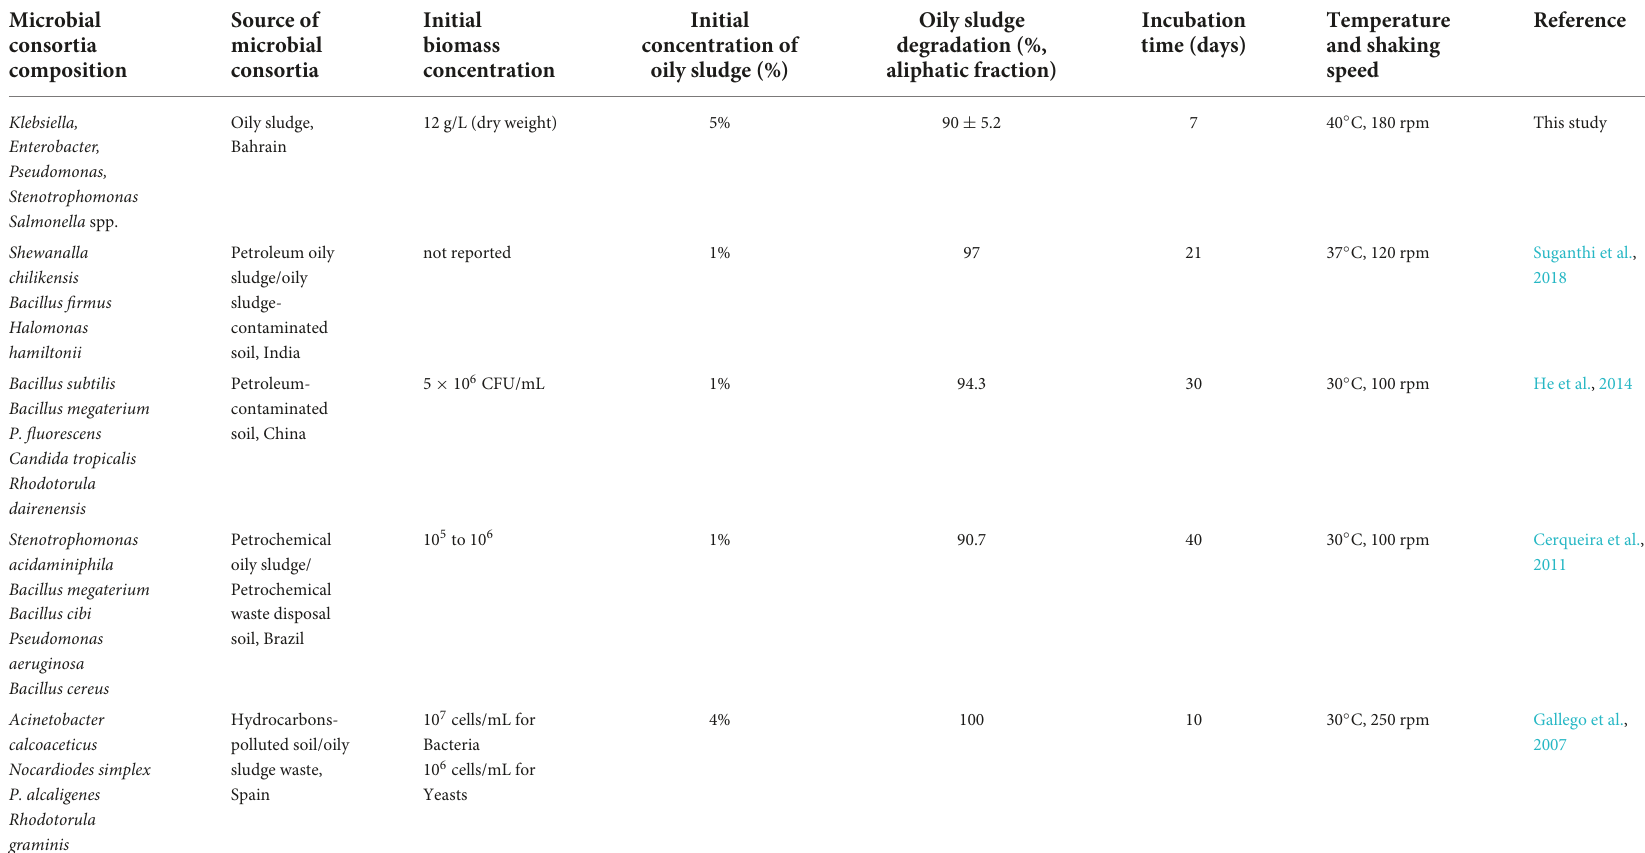
Incubation time (days)